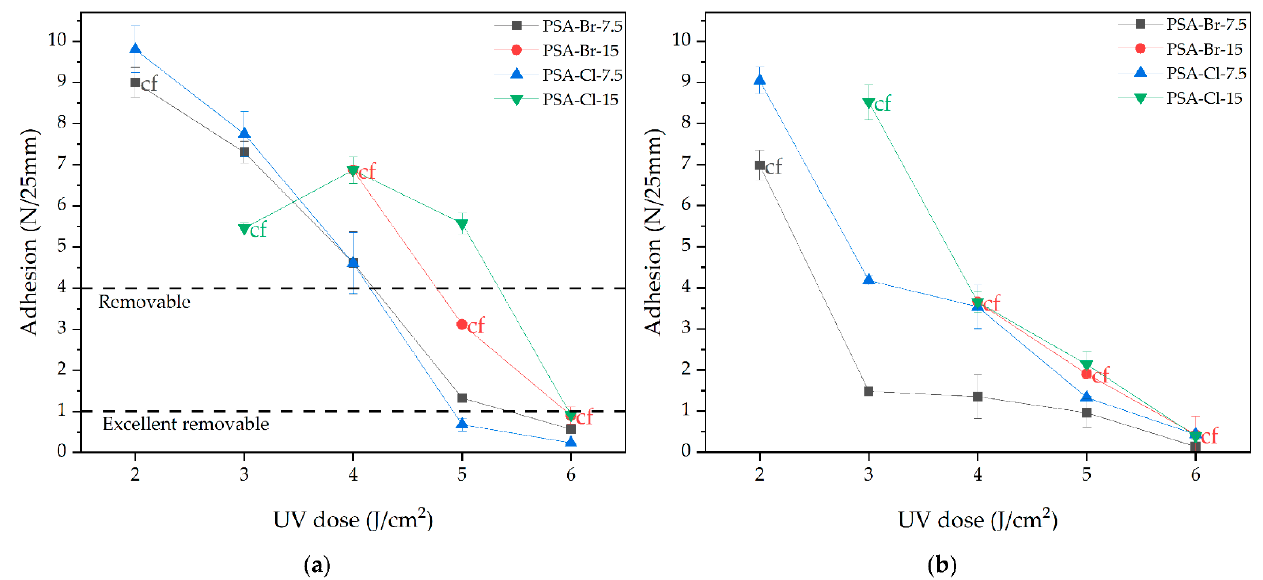
Figure 4. Adhesion to steal at 180° ( a ) and tack ( b ) tack of PSAs based on acrylic telomer syrups.